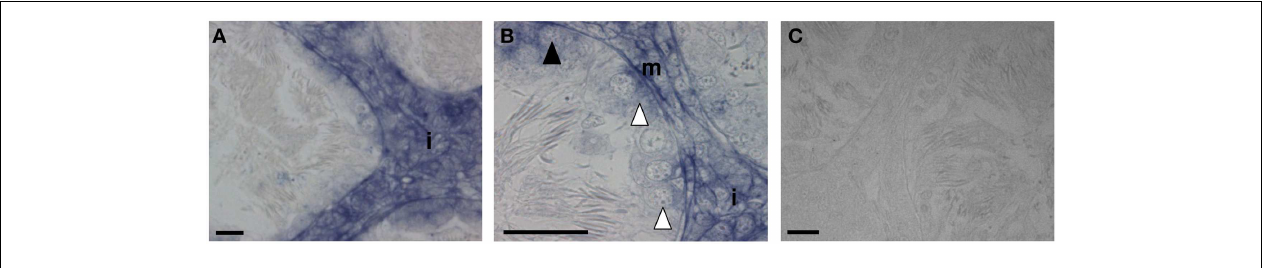
myoid peritubular cells (B) .The specificity of signals was tested through the reaction with a sense riboprobe (C) . i, Interstitial compartment; white arrow head, ISPG; dark arrow head, IISPG; m, myoid peritubular cells; scale bar: 20 µ